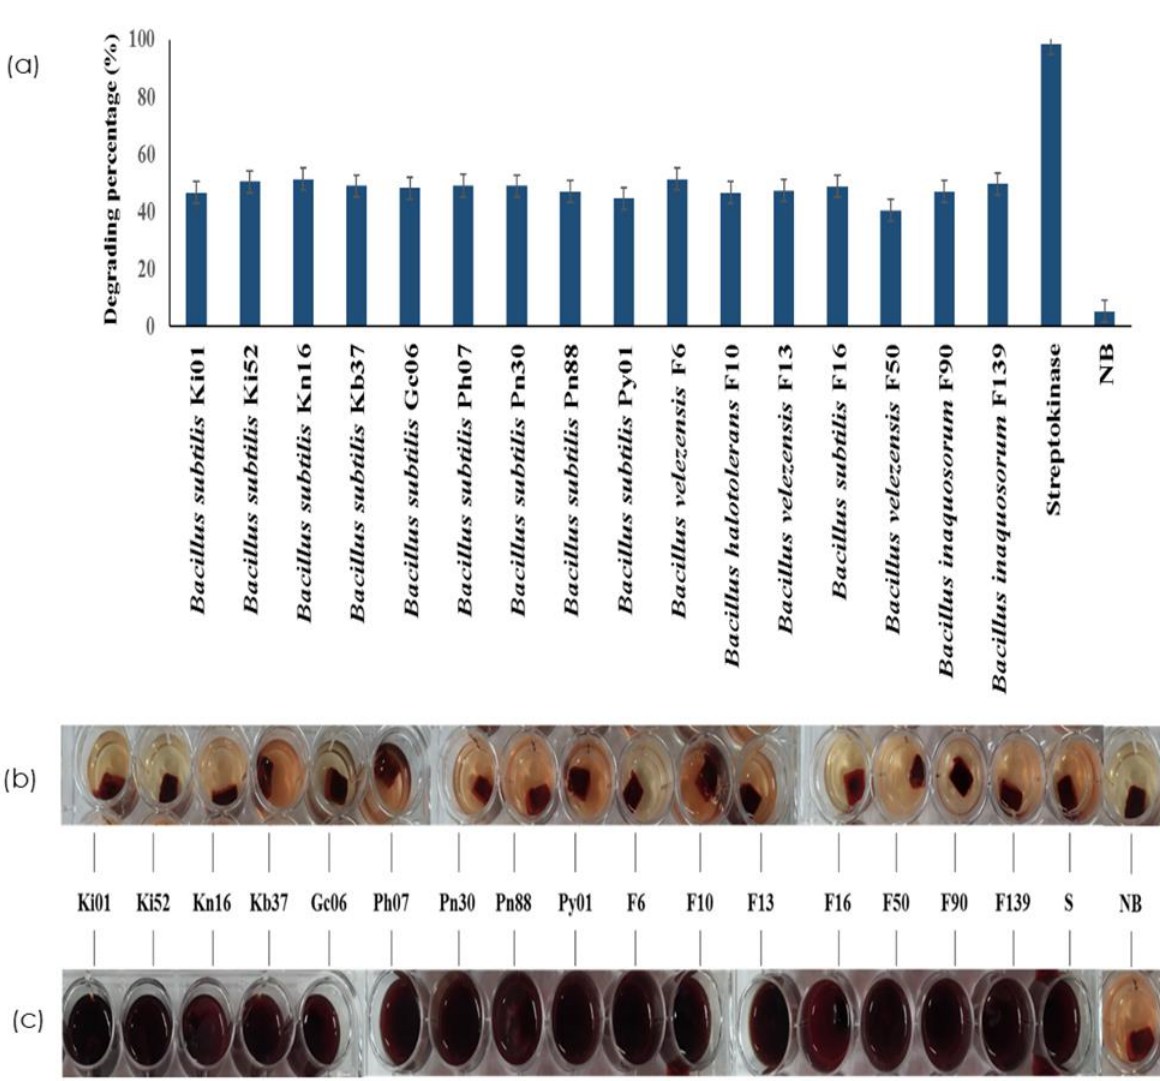
Figure 3. ( a ) Crude extracts of Bacillus spp. (as the source of fibrinolytic enzymes) exert properties that degrade the whole blood clot; Streptokinase (S) was used as positive control and nutrient broth (NB) as negative control ( b ) Visual observation of the results on whole blood clots treated with crude extracts of Bacillus spp. at 0 h incubation; ( c ) after 18–24 h incubation.